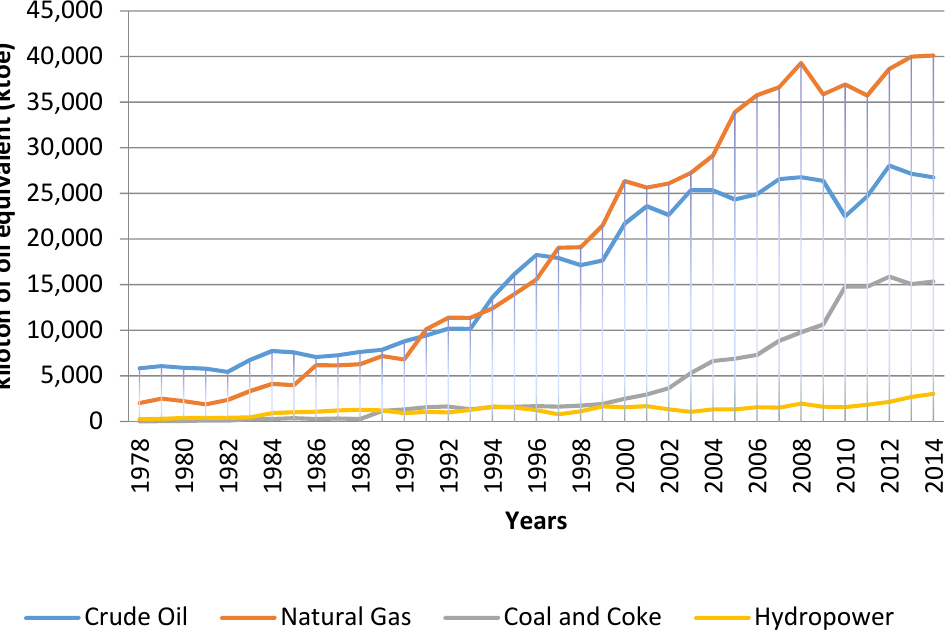
Figure 1. Sources of primary energy supply in Malaysia (source: Malaysia Energy Information Hub [3]).